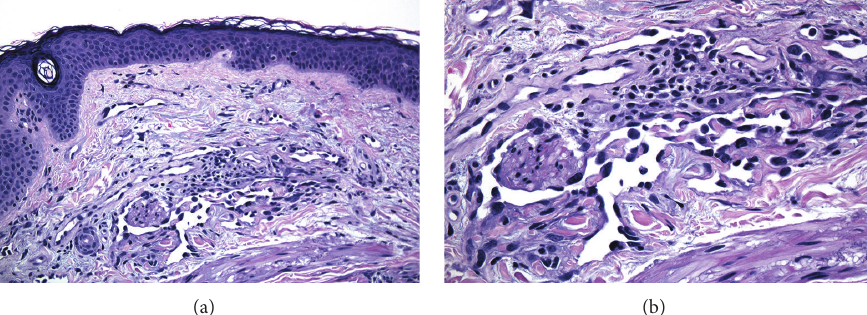
Figure 3: Scouting biopsies revealed a subtle infiltration in the superficial dermis with poorly formed malignant vascular structures similar to those seen at the periphery of the main tumor.